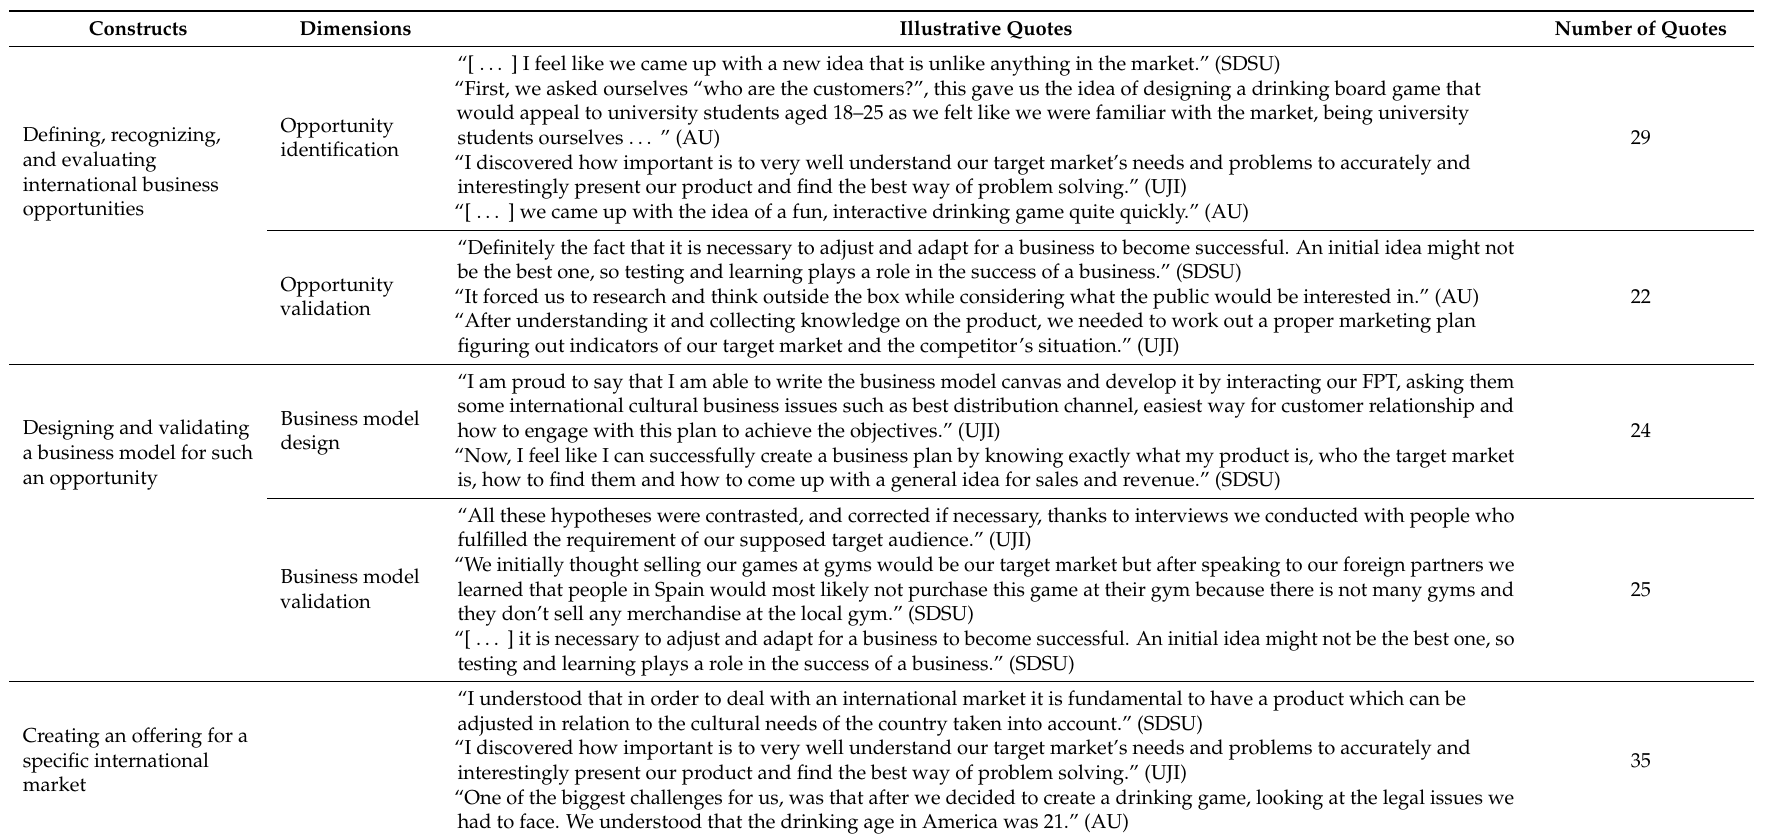
Table 4. Results of the qualitative